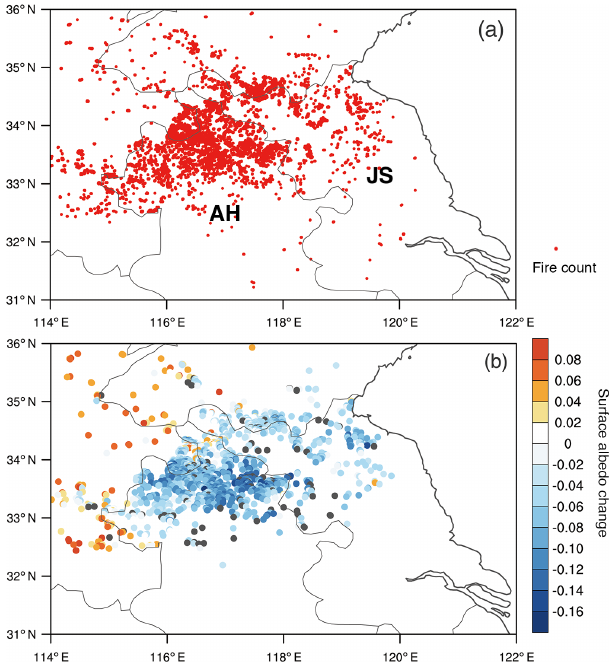
Figure 2. (a) Accumulated satellite fire counts with high-confidence from 24 May to 17 June in 2012. (b) Surface albedo changes for the period by MOD09A1 over the corresponding burned area in panel (a) . Declines equal values on 17 June minus those on 24 May. Note that a certain uniform data interval was adopted considering the dots’ density.